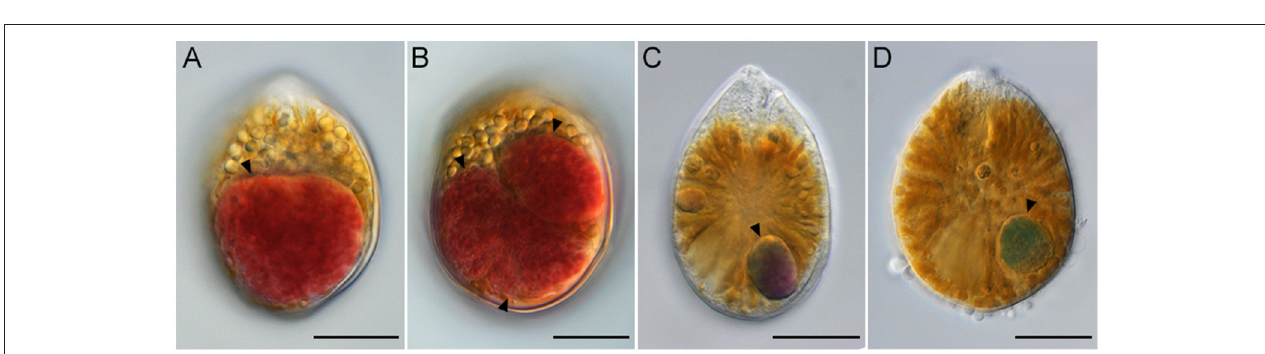
FIGURE 5 | Light micrographs of Ostreopsis cells with the ingested food particles (arrowheads) from field samples. In (B) three food particles are visible inside an Ostreopsis cell. The ingested food particles within Ostreopsis cells were reddish brown (A,B) , purple (C) , and blue-green (D) . Scale bars = 20 µ